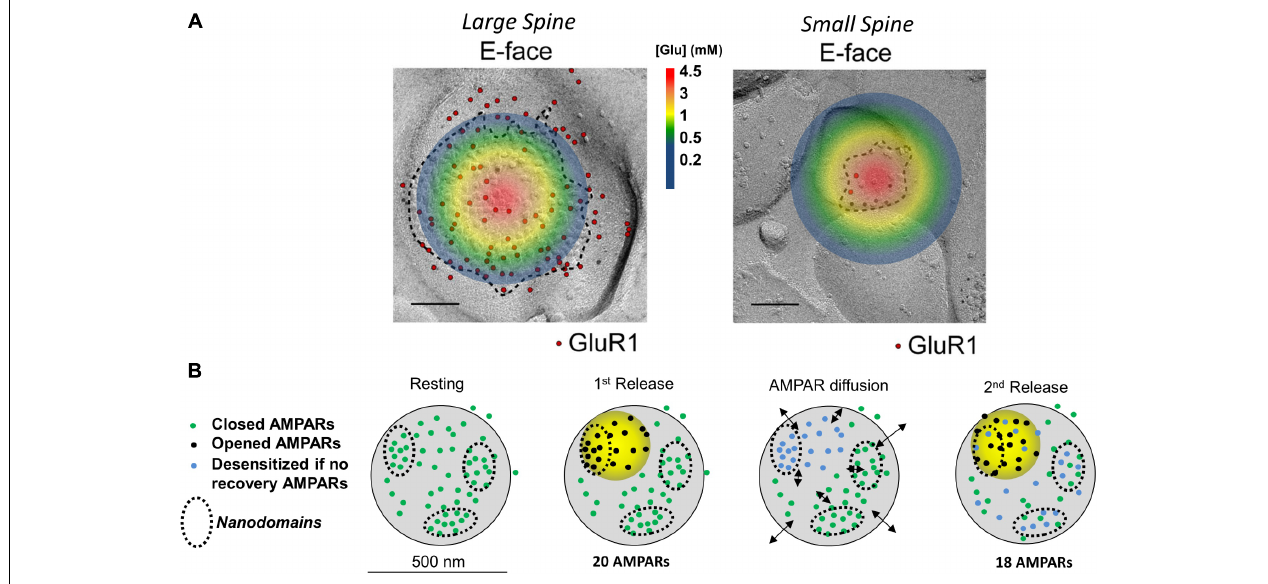
FIGURE 1 | Image and legend reprinted from Shinohara and Hirase (2009). (A) Examples of paired SDS-digested freeze-fracture replica labeling (SDS-FRL) for GluR1 (E-face) at large vs. small spines in CA1 of stratum radiatum synapses (old nomenclature for AMPAR subunits is used). Colored circle represents the extent of glutamate spread 50 µ s post vesicular fusion as predicted by Raghavachari and Lisman (2004). Approximate colored scaled for glutamate concentrations shown in between images (in mM). Scale bars: 100 nm. (B) Conceptual model of AMPAR mobility during paired-pulse stimulation. Diagram of a large mushroom spine with realistic AMPAR content randomly distributed thought the space in small nanodomains (black circles). Zone of high glutamate concentration is illustrated by the yellow circle and should follow the color schemed shown above. Three different states for AMPAR are assigned: closed (green color), opened (black), and desensitized (blue). Four states are shown: resting (left), 1st release, AMPAR diffusion, and 2nd release. Estimated synaptic response is shown above as a one to one correspondence between number of AMPAR and size of